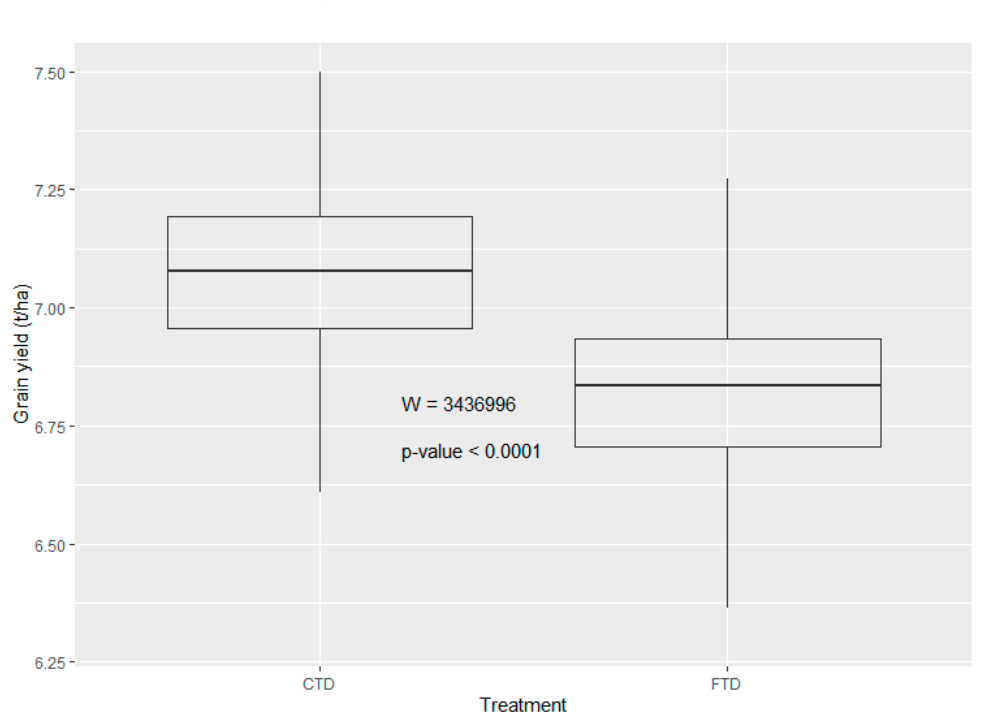
Figure 9. Box plots of grain yield with Mann-Whitney U test (W, p-value) at CTD and FTD sites with Dystric Cambisol in the Za Frajmankou field from the yield map taken on 15 August 2021.